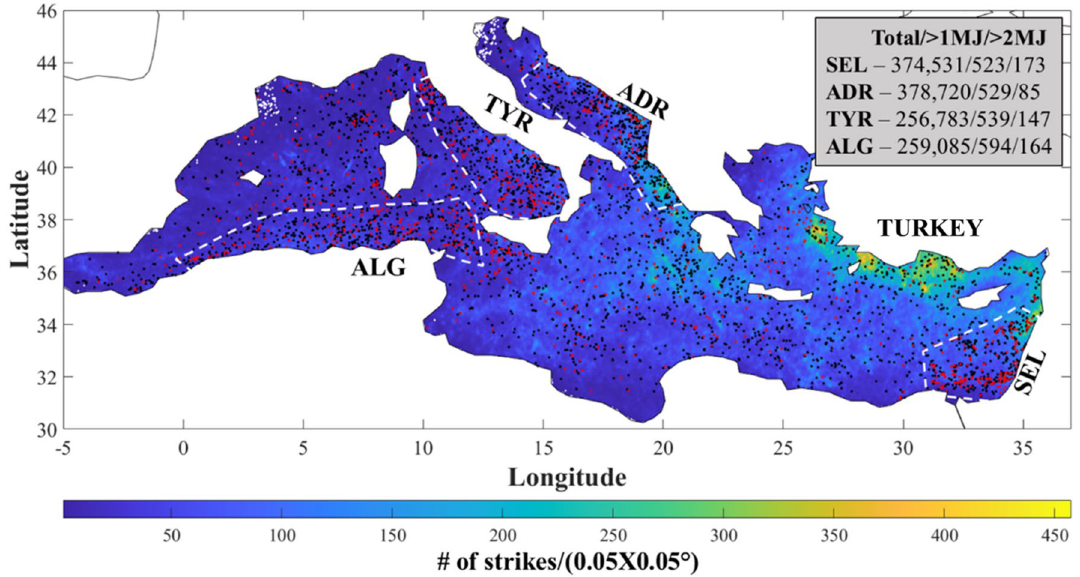
Figure 1. The spatial distribution of superbolts and cloud to ground lightning flash density over the Mediterranean sea during the winter months (DJF), observed by WWLLN over the period 2009–2021. The black and red dots indicate the locations of lightning flashes with energies > 10 6 and 2 × 10 6 Joules (superbolts), respectively. The dashed white lines indicate the regions with apparently higher frequencies of superbolt events in the Southeastern Levantine Sea (SEL), Southern Adriatic Sea (ADR), the Tyrrhenian Sea (TYR) and along the Mediterranean coast of Algeria (ALG). The numbers in the inset box indicate the total # of flashes/# of flashes with energies > 10 6 Joules/# of flashes with energies > 2 × 10 6 Joules, for each of the highlighted regions in the